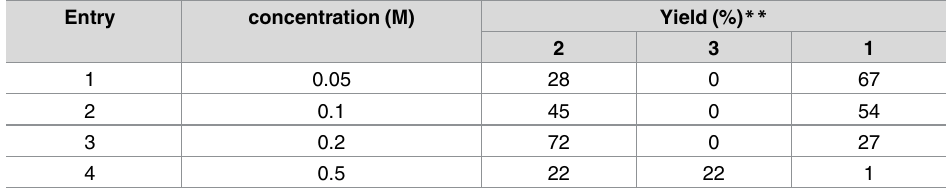
Table 3. Optimization of the reaction concentration.